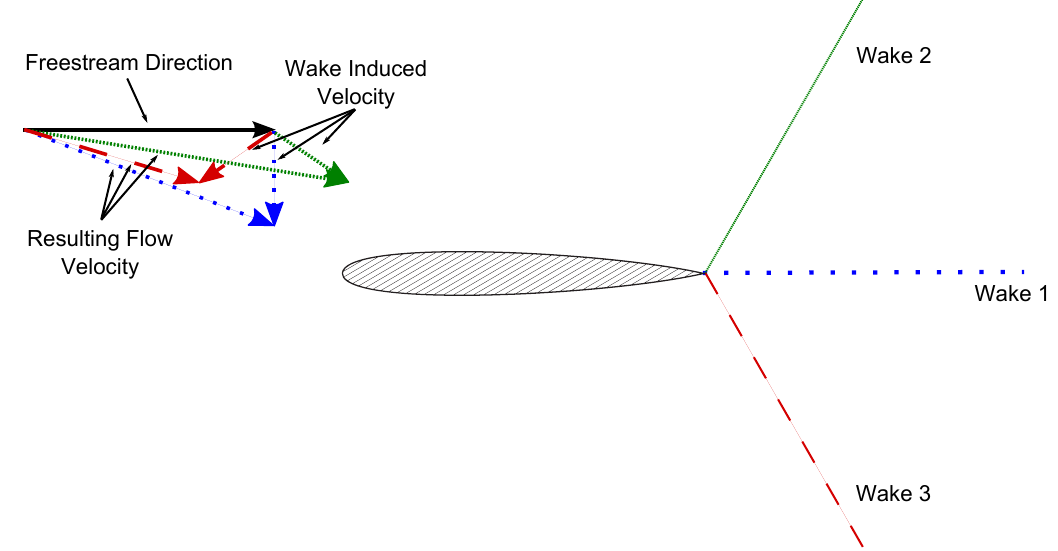
Figure 9. Effect on incoming flow velocity due to three prescribed wake shapes of equal strength